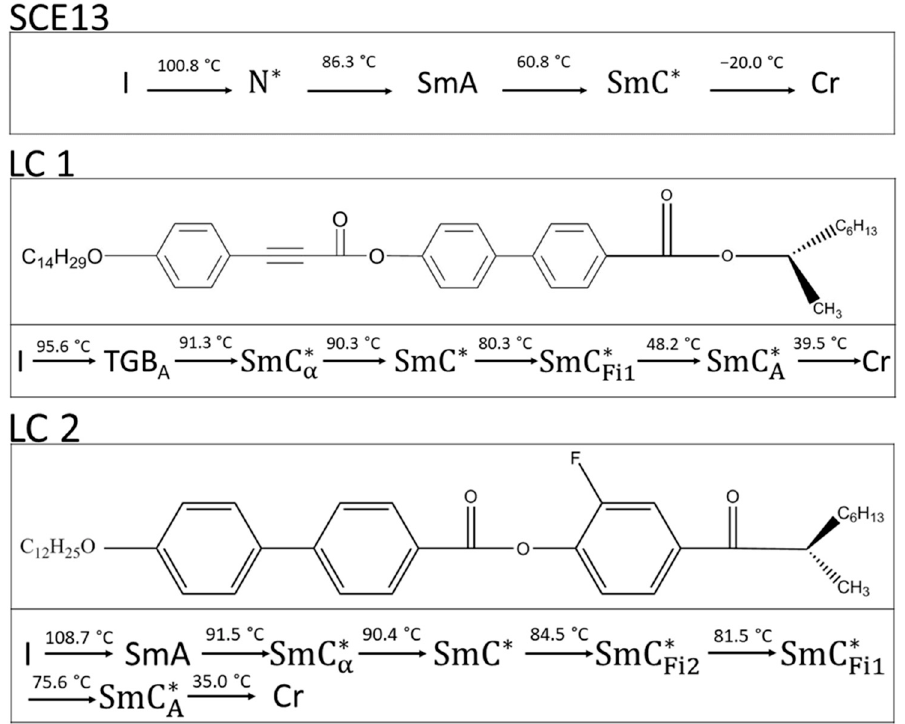
Figure 1. The phase transitions (measured on cooling) for all three materials studied, together with the chemical structure of LC 1 and LC 2. The notation of the phases is as defined in the text, with the following: Cr is crystal; SmC* Fi1 is the 3-layer intermediate phase; SmC* Fi2 is the 4-layer intermediate phase; SmC* A is the antiferroelectric phase.